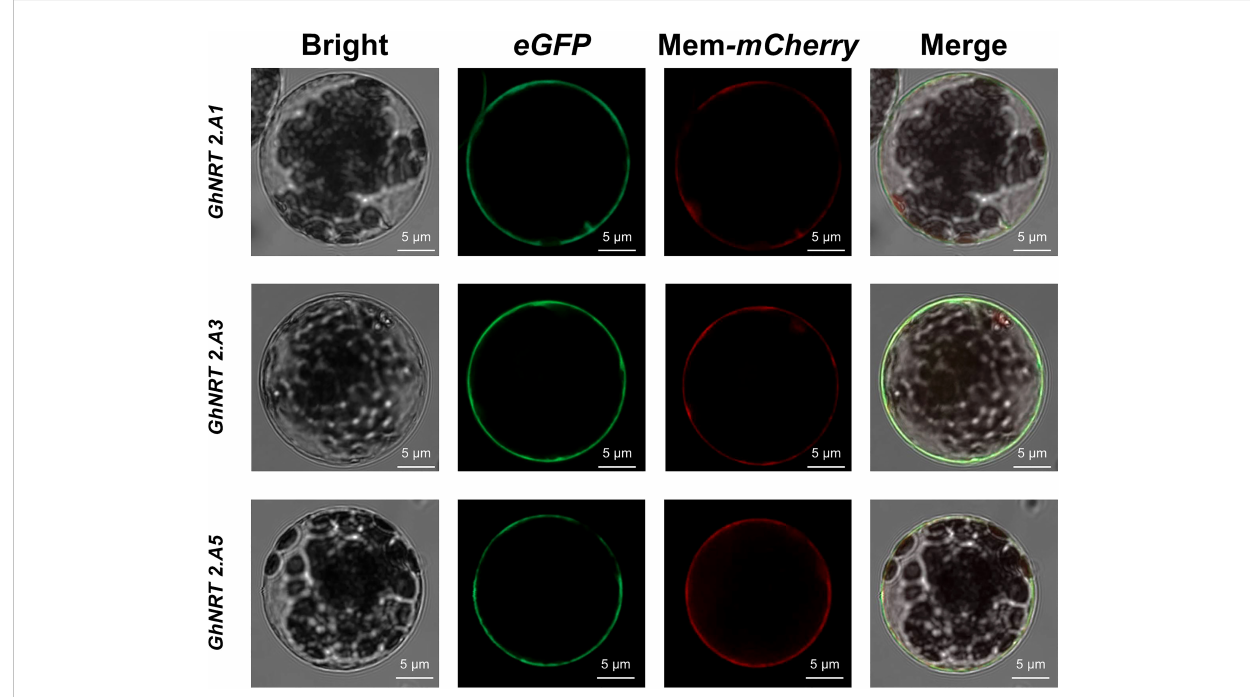
FIGURE 6 GhNRT2s genes Subcellular localization. Subcellular localization assay with cotton protoplast using the pCaMV35S:: GhNRT2.A1 / GhNRT2.A3/ GhNRT2.A5 -eGFP construct. Red fl uorescence is mCherry of membrane localization. Scale bars = 5